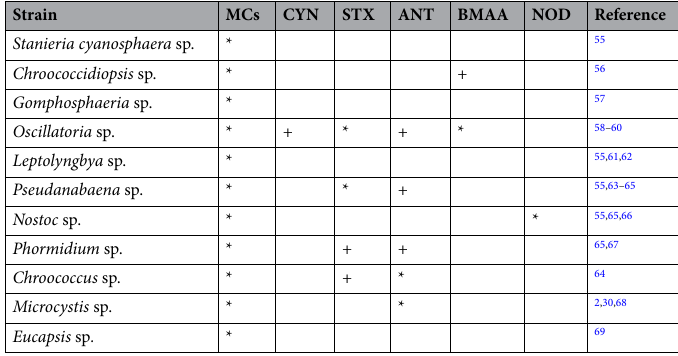
Table 4. Toxic cyanobacterial species and their potential cyanotoxins. * MCs microcystins, CYN Cylindrospermopsin, SXT saxitoxin, ANT anatoxin-a, BMAA β-N-methylamino-L-alanine, NOD nodularin.